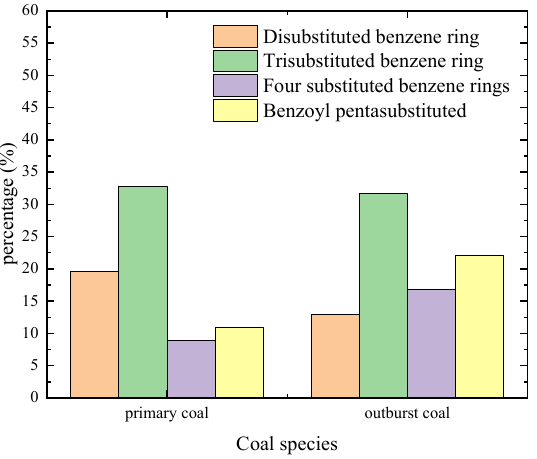
Figure 4. Statistical distribution of substituted benzene rings.